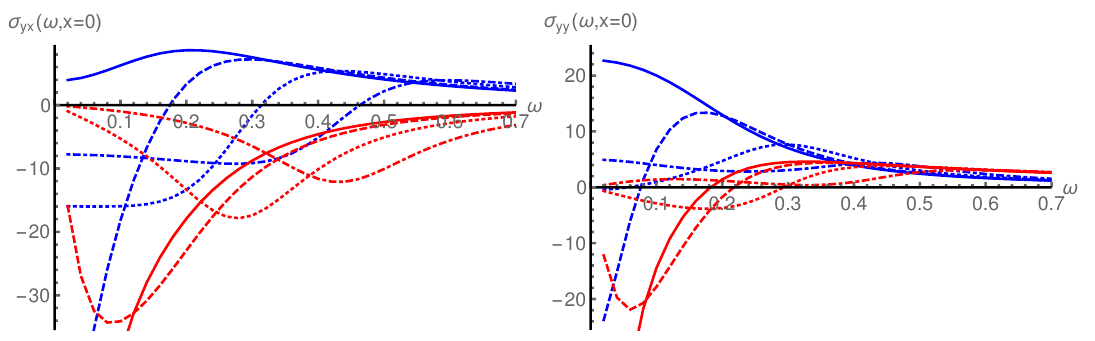
Figure 14 . The pinning effect due to the magnetic lattice on the components of the conductivity that do feature delta peaks, at b = 0 . 5 and x = 0 . The blue (red) curves are real (imaginary) parts, and the solid, dashed, dotted, and dot-dashed curves are for α b = 0 , 0 . 1 , 0 . 25 , and 0 . 5 , respectively. Left: the behavior of σ yx at x = 0 . Right: the behavior of σ yy at x = 0 .